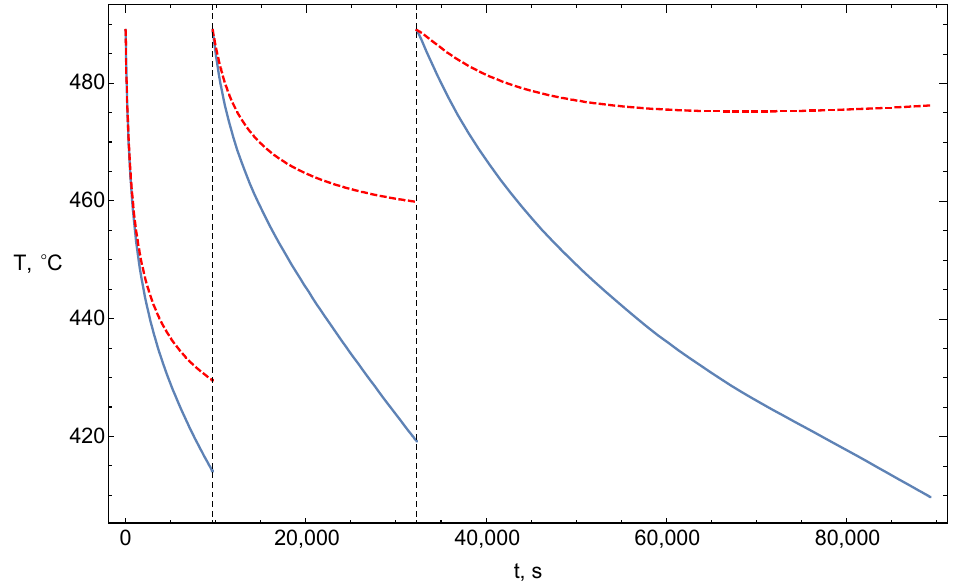
Figure 5. The reaction temperature in all three reactors for three different scenarios: red—no control; blue—obtained control; vertical dashed lines represent times in each reactor.